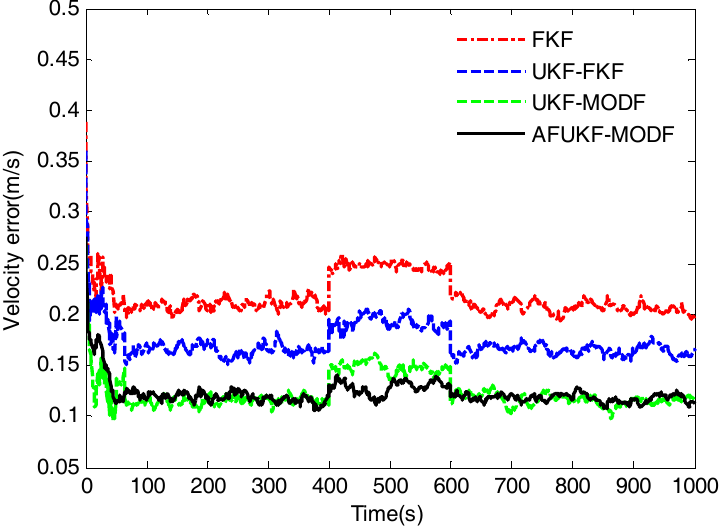
Figure 4. The RMSEs of overall velocity errors obtained by FKF, UKF-FKF, UKF-MODF and AFUKF-MODF for the simulation case.